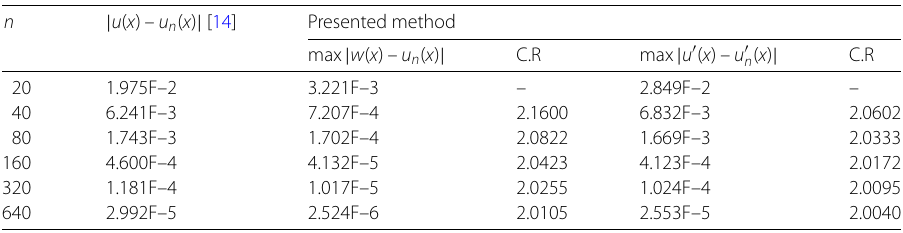
Table 3 Comparison of absolute errors in Example